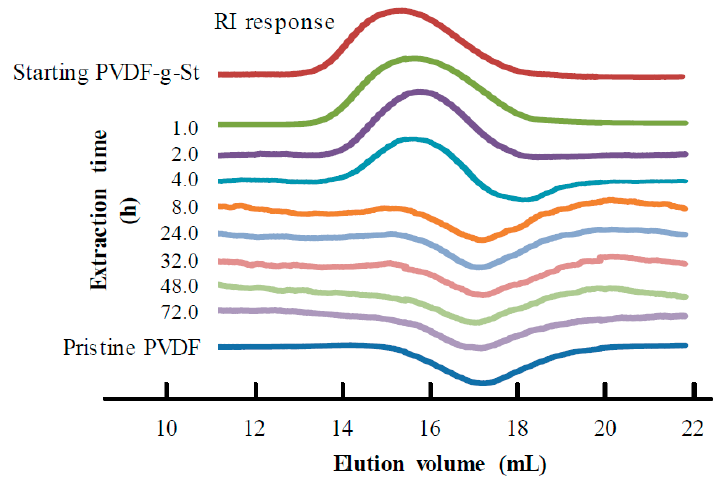
Figure 7. GPC traces of the residual PVDF– g –St films with different extraction times, corresponding starting PVDF– g –St film, and pristine PVDF film. Eluent, 10 mM LiBr in DMF; flow rate, 1.0 mL/min; column temperature, 40 ° C; RI detector.